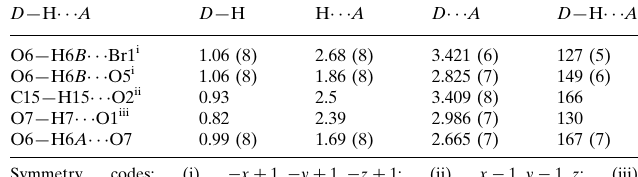
Hydrogen-bond geometry (A˚ , (cid:2)